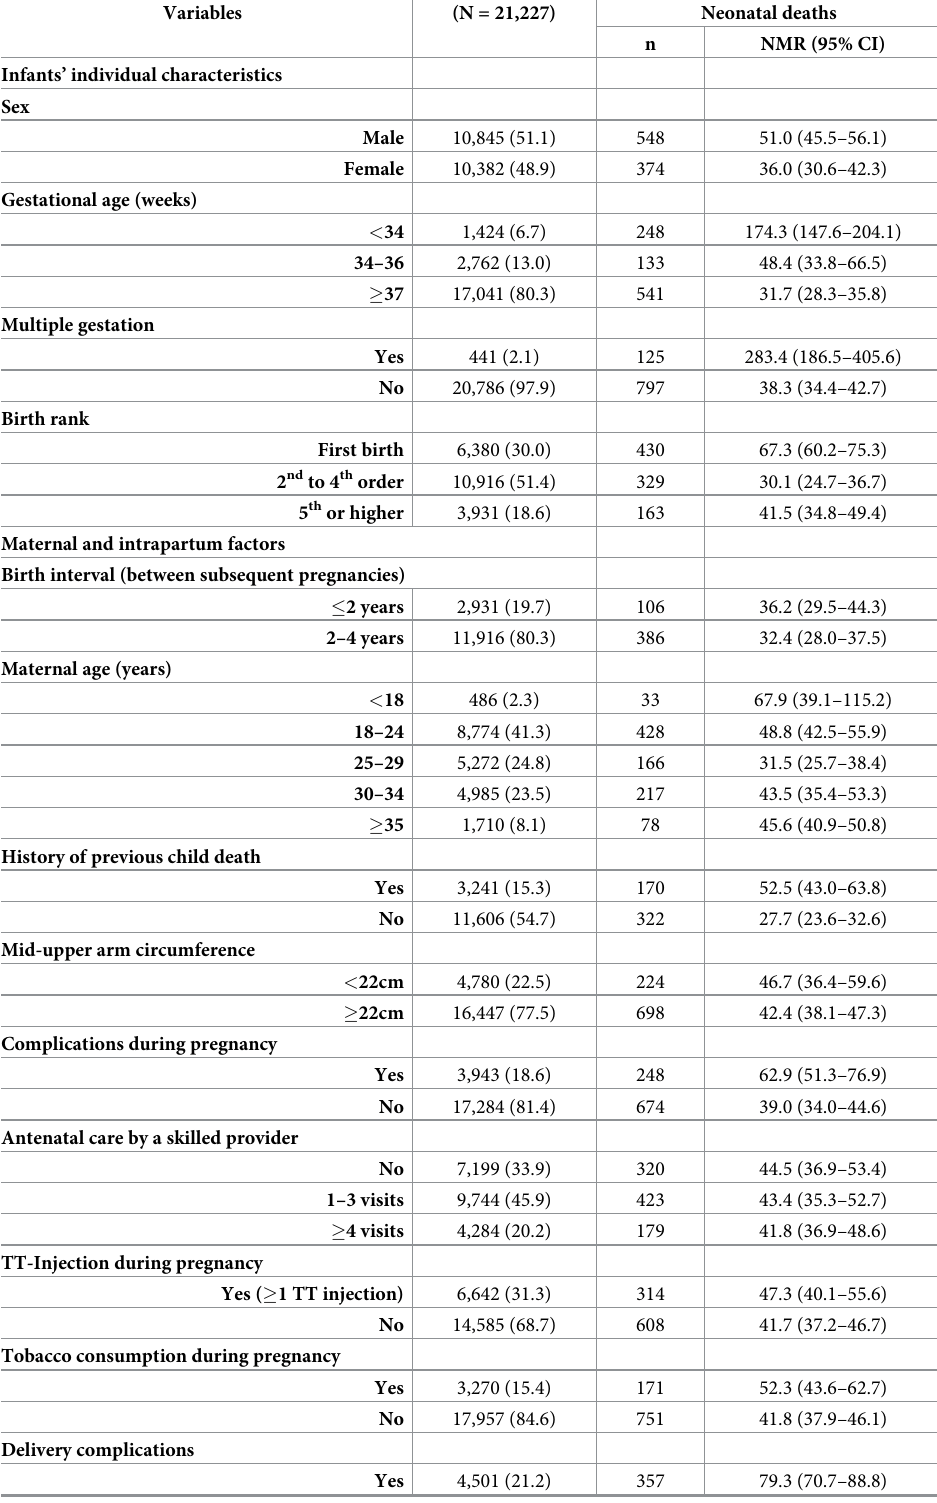
Table 1. Distribution of individual, maternal and socioeconomic characteristics along with NMR (95%